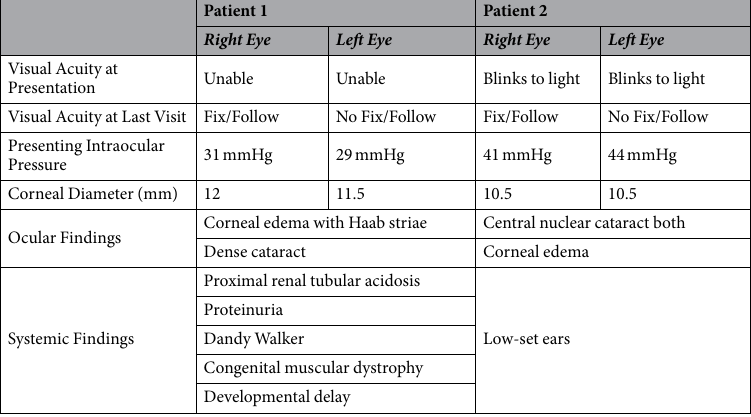
We also identified another novel deletion mutation in Lowe 2 patient (c. 1595-1631del, p. Tyr477Leu fsX) (Fig. 4B). This 37-basepair mutation site localized at the tail of exon 14, which caused another reading frameshift at amino acid 477 in the 5-phosphatase domain, resulted in a truncated protein of 506 amino acids. OCRL Protein Analysis for Lowe patients. OCRL is a multi-domain protein comprising an N-terminal pleckstrin homology (PH) domain followed by a central inositol-5-phosphatase domain, an ASPM-SPD-2-Hydin